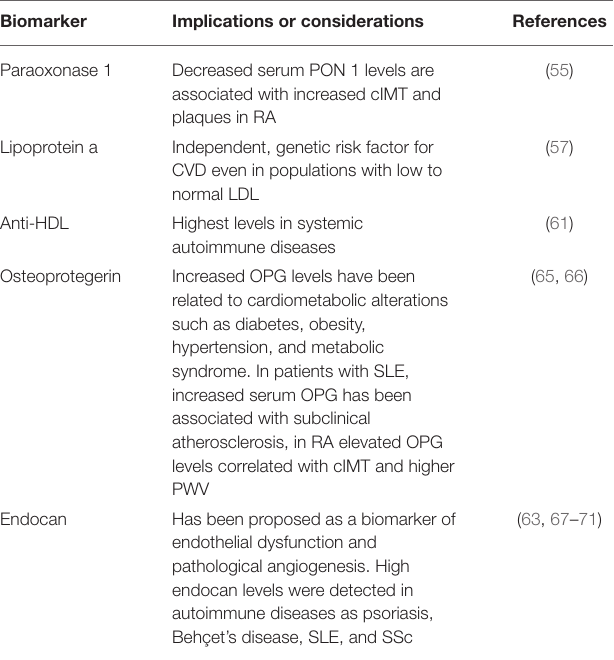
TABLE 1 | Recently identified potential biomarkers of inflammation and endothelial dysfunction in rheumatic diseases.